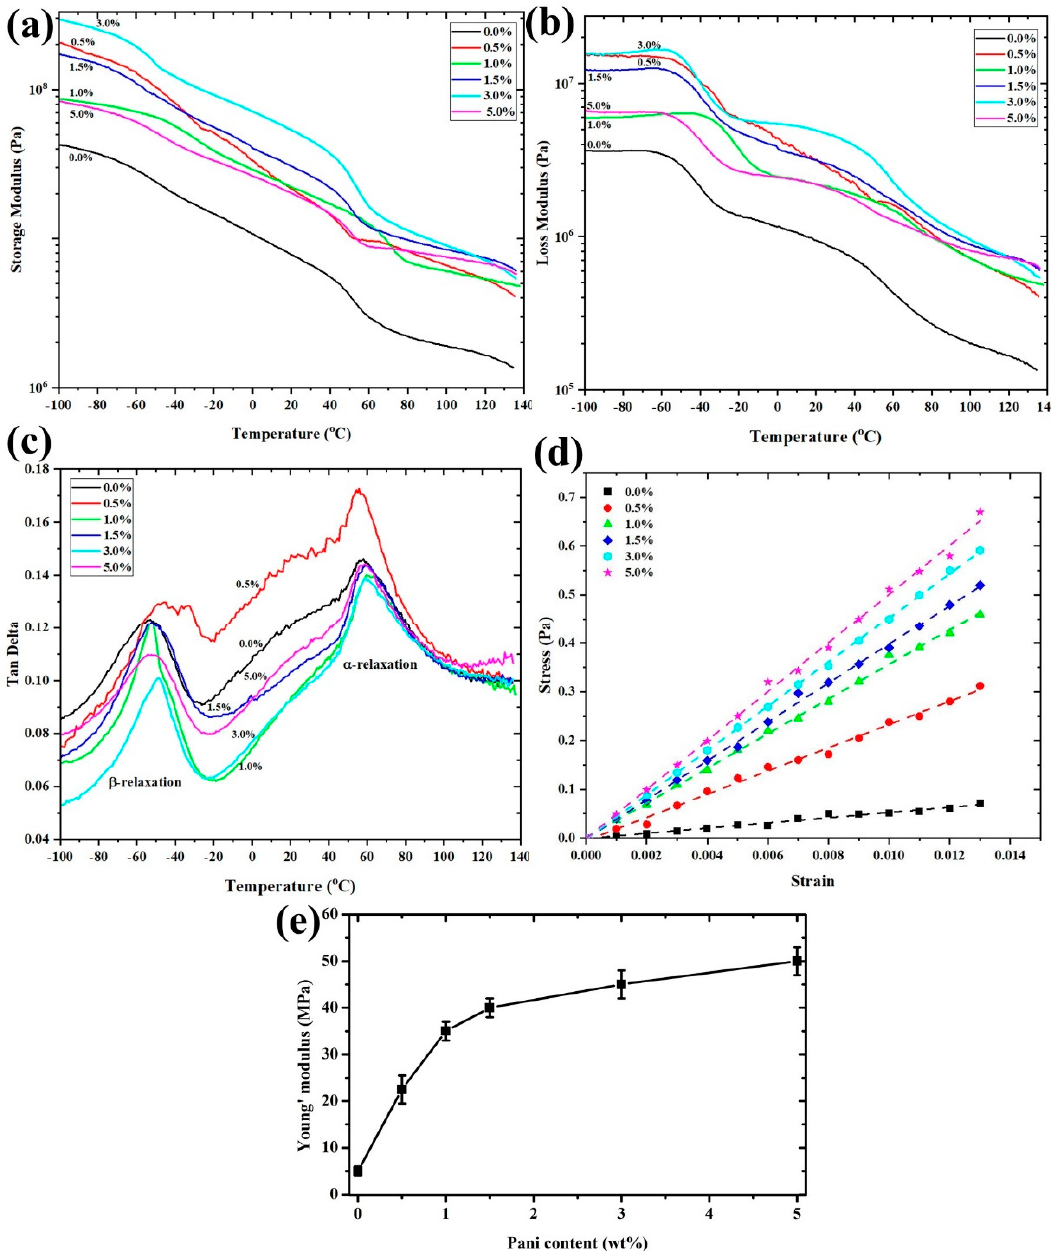
Figure 6. DMA curves of pure P(VDF-HFP) and P(VDF-HFP)/PANI composite nanofiber as a function of temperature; observed ( a ) storage modulus, ( b ) loss modulus, ( c ) tan delta, ( d ) stress–strain curves and ( e ) Young’s modulus of the samples versus weight fraction of PANI.